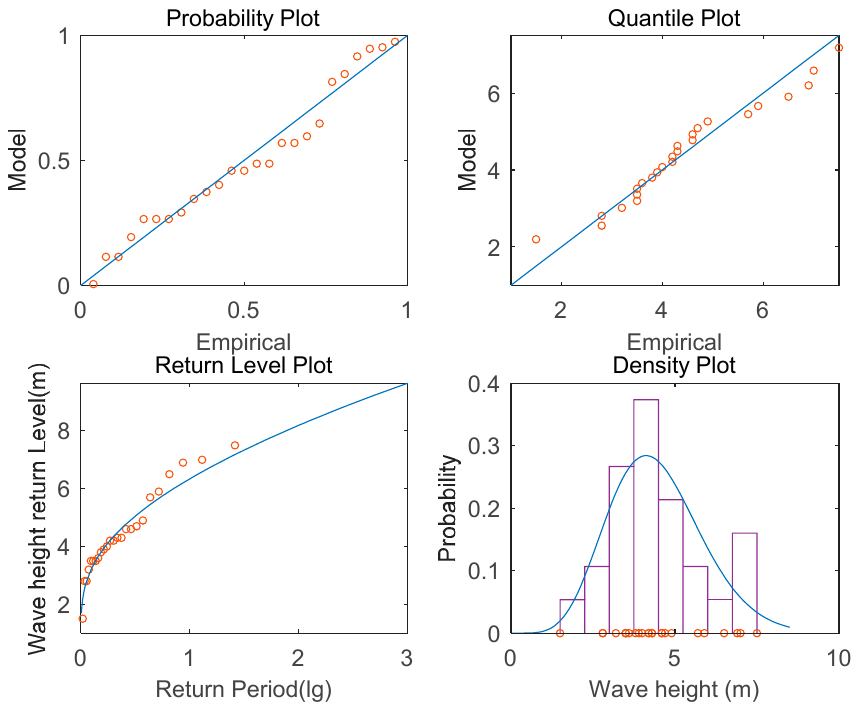
Figure 6. Inspection diagram of annual extreme wave height data of Maximum Entropy distribu- tion.